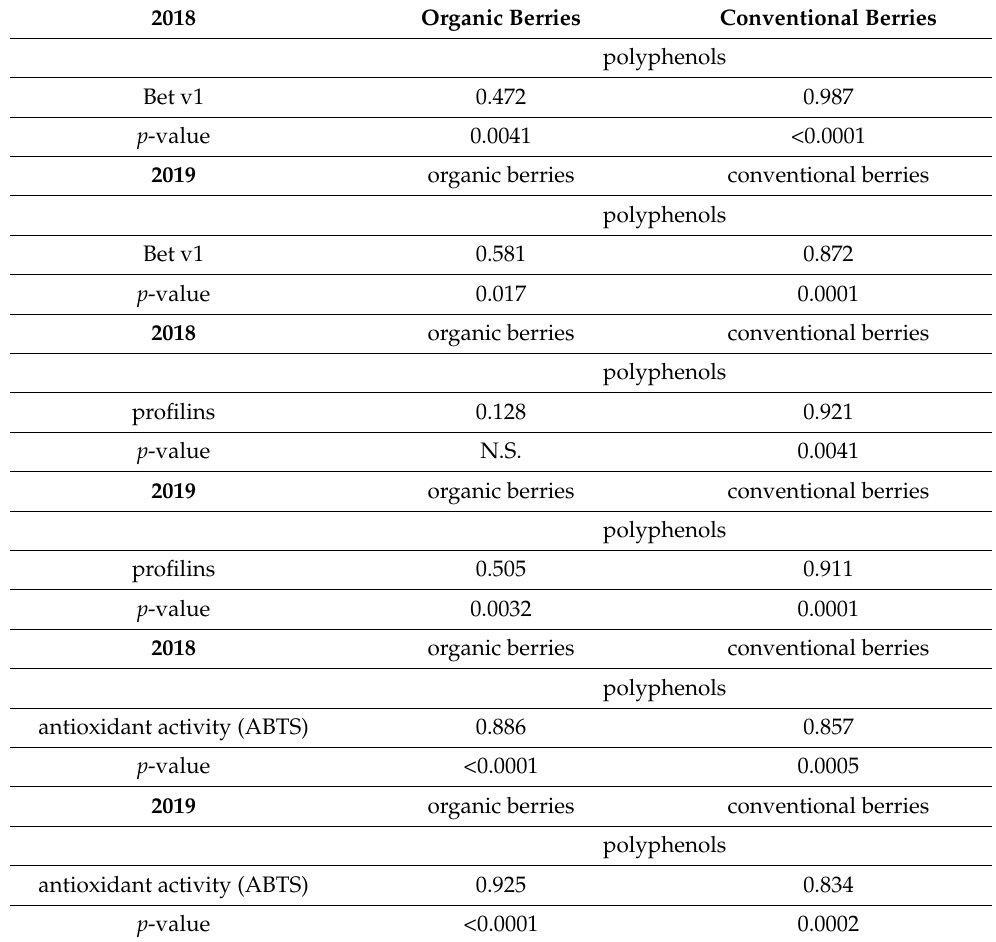
Table 4. Pearson’s coefficient (R 2 ) between anti-allergenic potency, antioxidant activity and total polyphenols in organic and conventional blue honeysuckle fruits in 2018 and